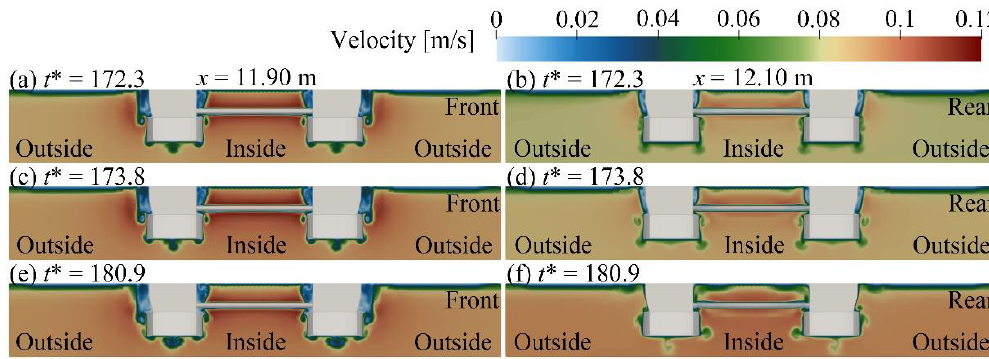
Figure A3. Velocity around the platform at y = 0.3 m and y = 0.4 m for Case A2. Appendix B. The Velocity Field around the Platform Located at Different Angles This appendix presents the velocity field around the semi-submersible platform located at different angles induced by the ISW propagation at *t = 173.83. Figure A4 illustrates the velocity field around the platform at the sections in z = 0.95 m and z = 0.97 m. The velocity fields around the same kind components of each platform are similar. The distributions of the velocity fields around the platform located at the 30°- and 60°-direction are more complicated than those around the platform located at the 0°- and 90°-direction. Figure A4a – d indicates that the range of the velocity reduction around the platform increases with the increases in the θ . Figure A5 shows the velocity field around the platform at sections